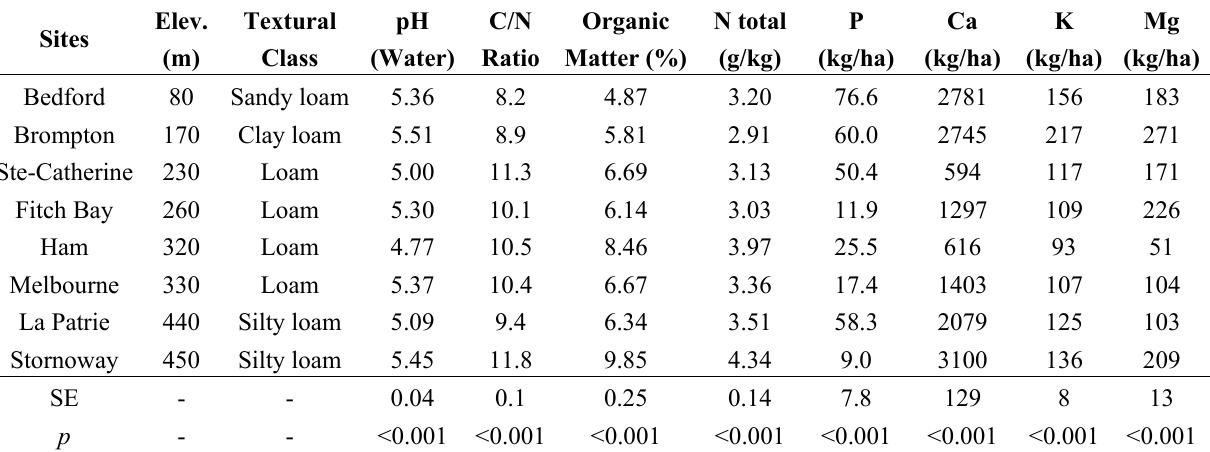
Table 1. Elevation (Elev.) and soil characteristics (0–15 cm) of the hybrid poplar plantation sites